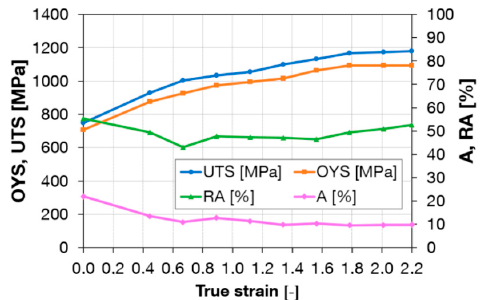
Figure 10. Tensile properties after one pass through the Conform SPD machine and after rotary swaging in relation to true strain.